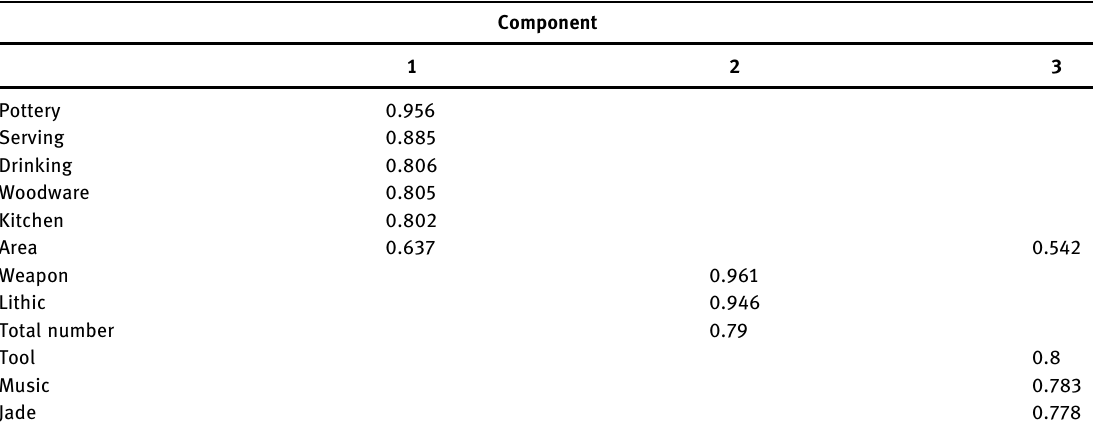
Table 3: Rotated signi fi cant component loadings of the variables